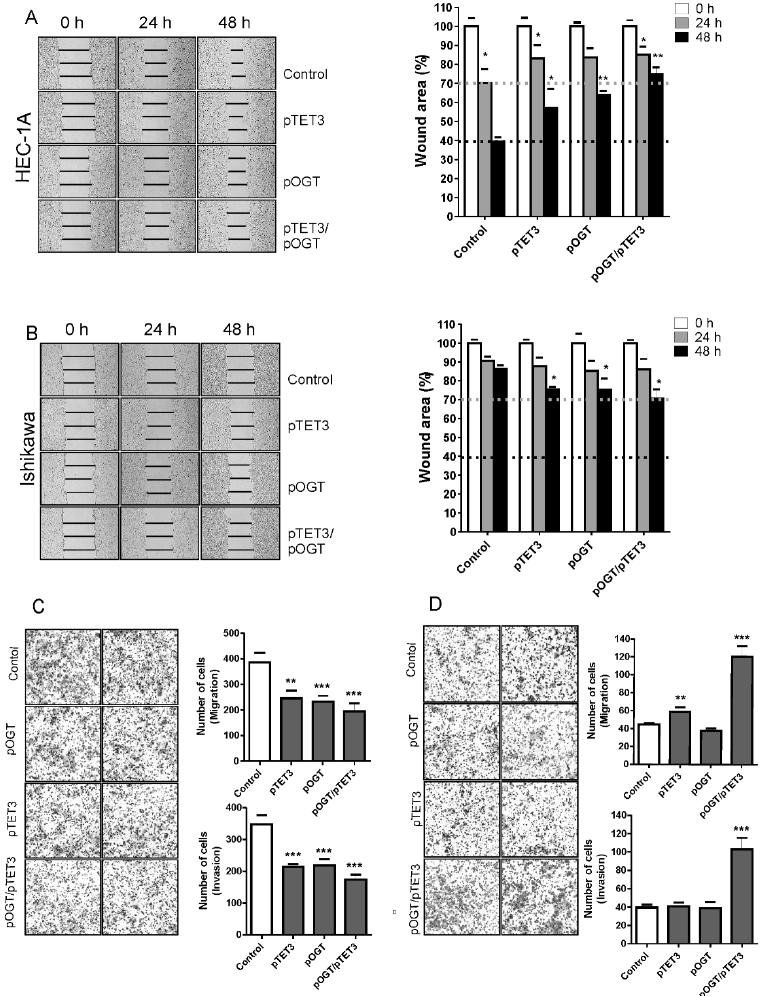
Figure 5. Effect of OGT and TET3 on migration and invasion of cells. The wound-healing assay was performed to examine the migration rate of HEC-1A ( A ) and Ishikawa cells ( B ) transduced with OGT and TET3 plasmid vectors. Photographs were taken at 0, 24 h, and 48 h following the initial scratch. Migration rates were quantified by measuring three different wound areas. Three separate experiments were performed. Cell migration assays using Transwell chambers and invasion assays using Transwell chambers with Matrigel were performed for HEC-1A ( C ) and Ishikawa cells ( D ). Representative images of migrating cells stained with Giemsa are displayed (left) for HEC-1A ( C ) and Ishikawa cells ( D ). Quantitative data of migration and invasion assay are expressed relative to the migration and invasion abilities of control cells. Plots show average counts from three independent testings * p < 0.01; ** p < 0.001; *** p <